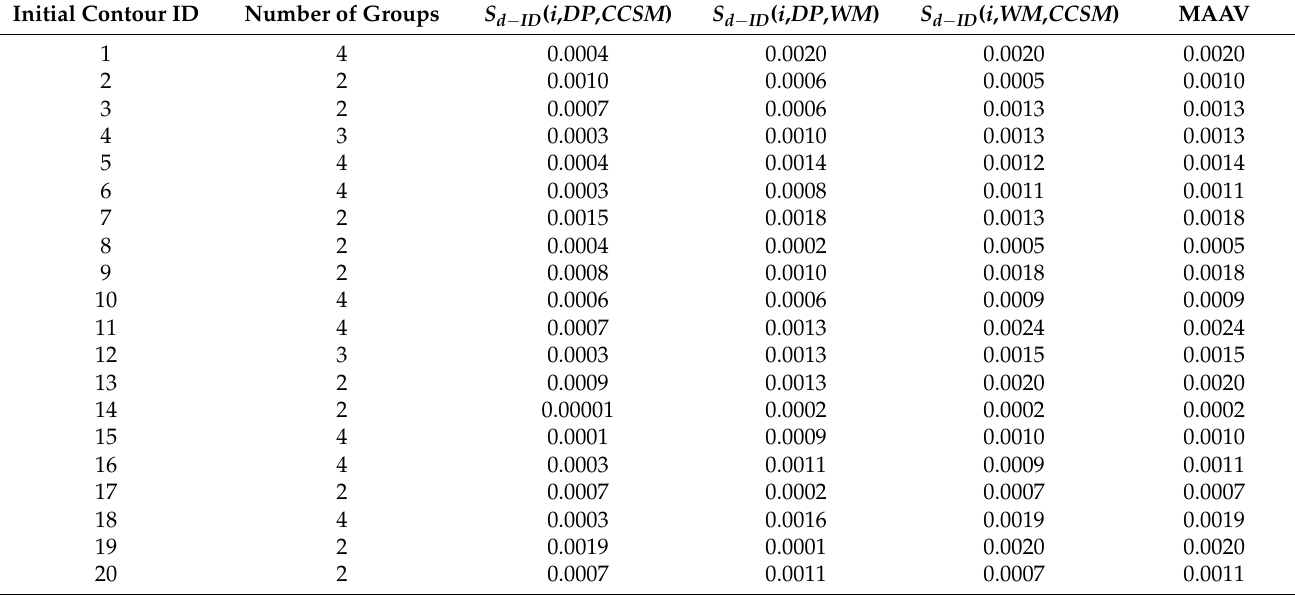
Table 2. Max average absolute value